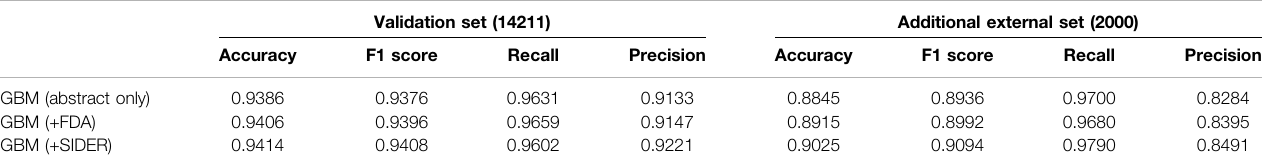
TABLE 2 | Results for the GBM model applied to the validation set and additional external sets of DILI and the non-DILI literature. The inclusion of FDA and SIDER datasets improved the GBM model. Validation set (14211) Additional external set (2000) Accuracy Recall Precision Recall Precision